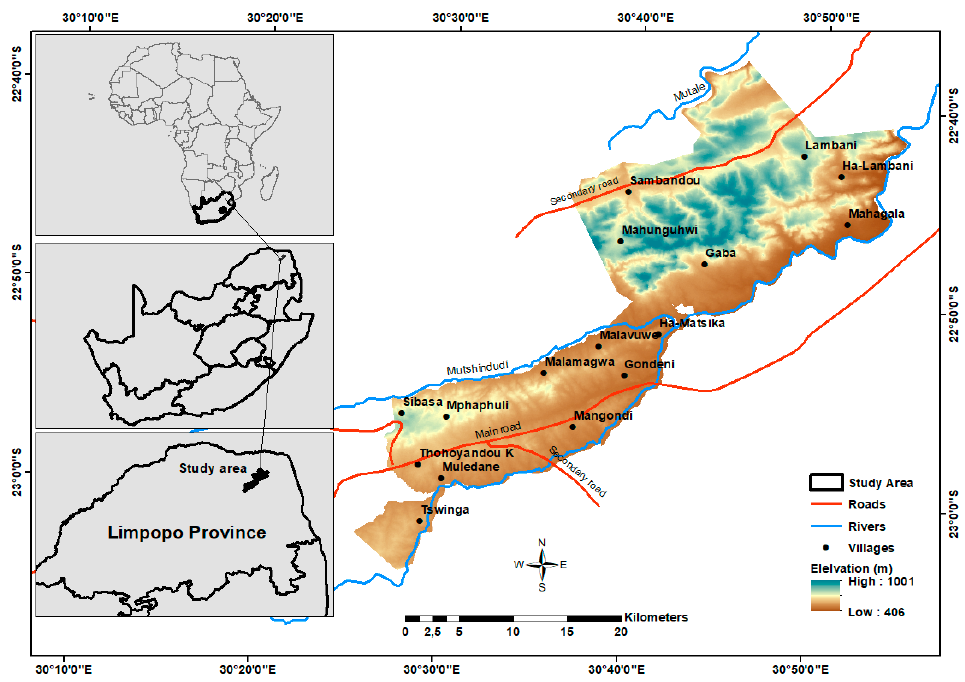
Figure 2. Location map of the study area [39] .